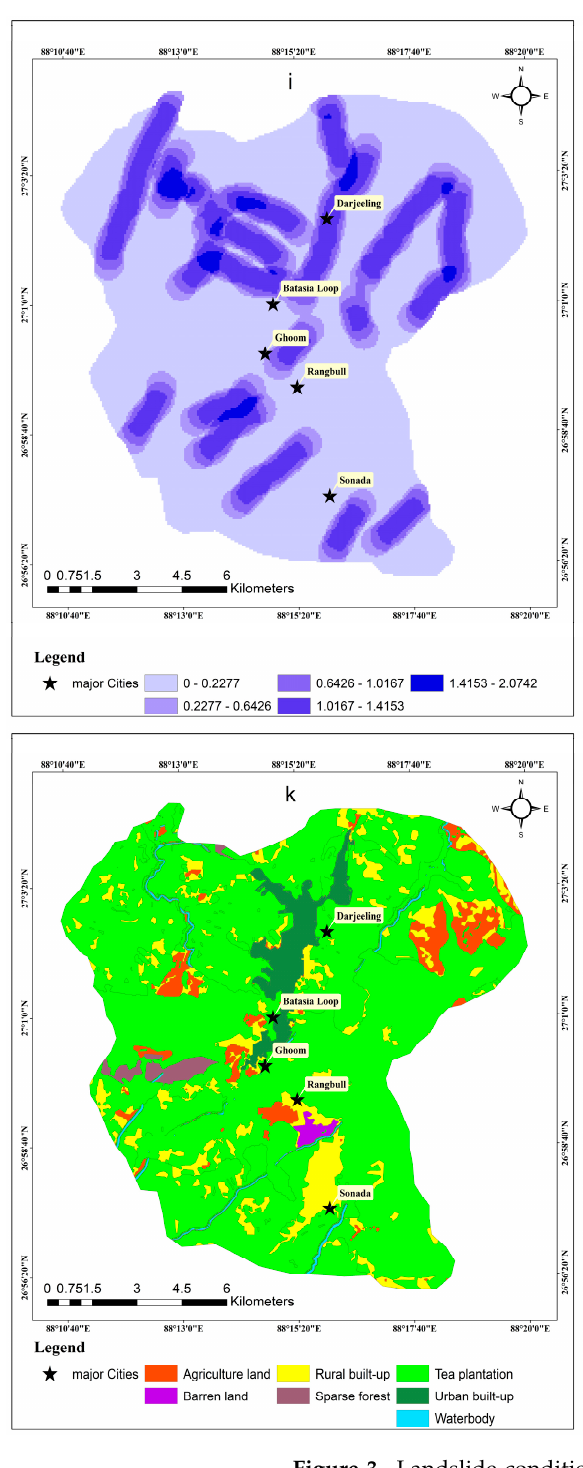
Figure 3. Landslide conditioning factors including landslide inventory: ( a ) landslide inventory; ( b ) slope; ( c ) aspect; ( d ) profile curvature; ( e ) drainage density; ( f ) soil texture; ( g ) geomorphology; ( h ) lithology; ( i ) lineament density; ( j ) rainfall; ( k )